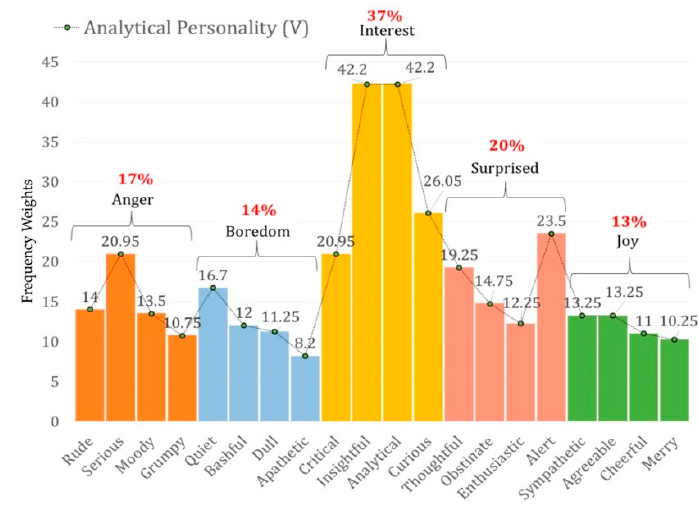
Figure 9. Analytical Personality (Factor V): behaviors at Level 3.